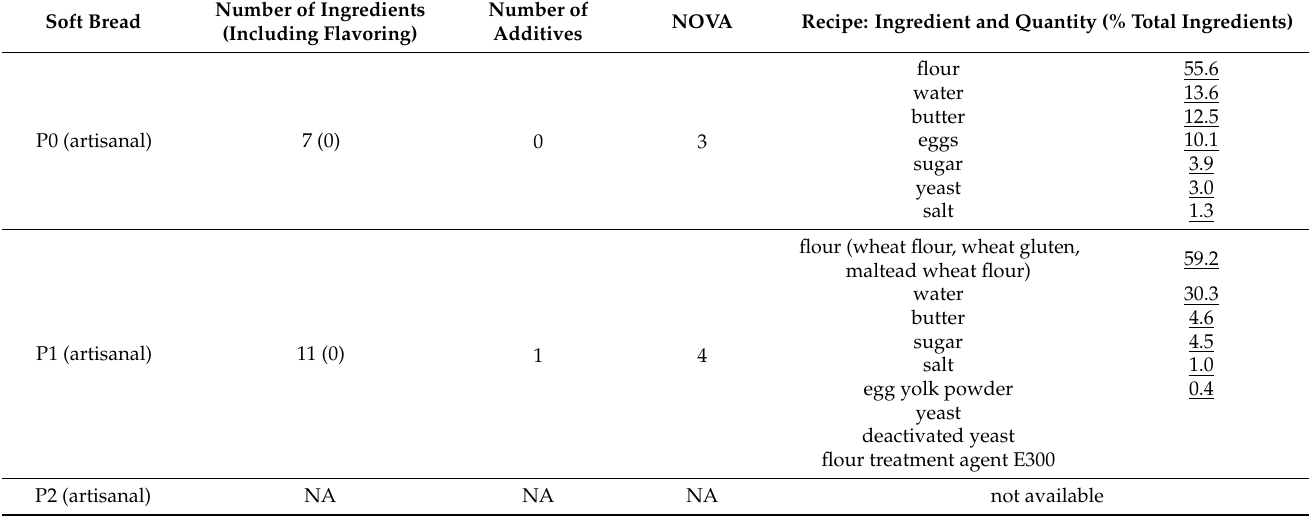
Table 1. Detailed recipes for the soft breads of industrial, artisanal, and homemade origins used in this study. * refers to organic ingredients. Proportions are underlined when calculated with the Anatole © software. The number of ingredients (including flavoring, if present), additives, and NOVA categories are indicated for each bread. NA: not applicable. Number of Ingredients NOVA Recipe: Ingredient and Quantity (% Total Soft Bread (Including Flavoring)